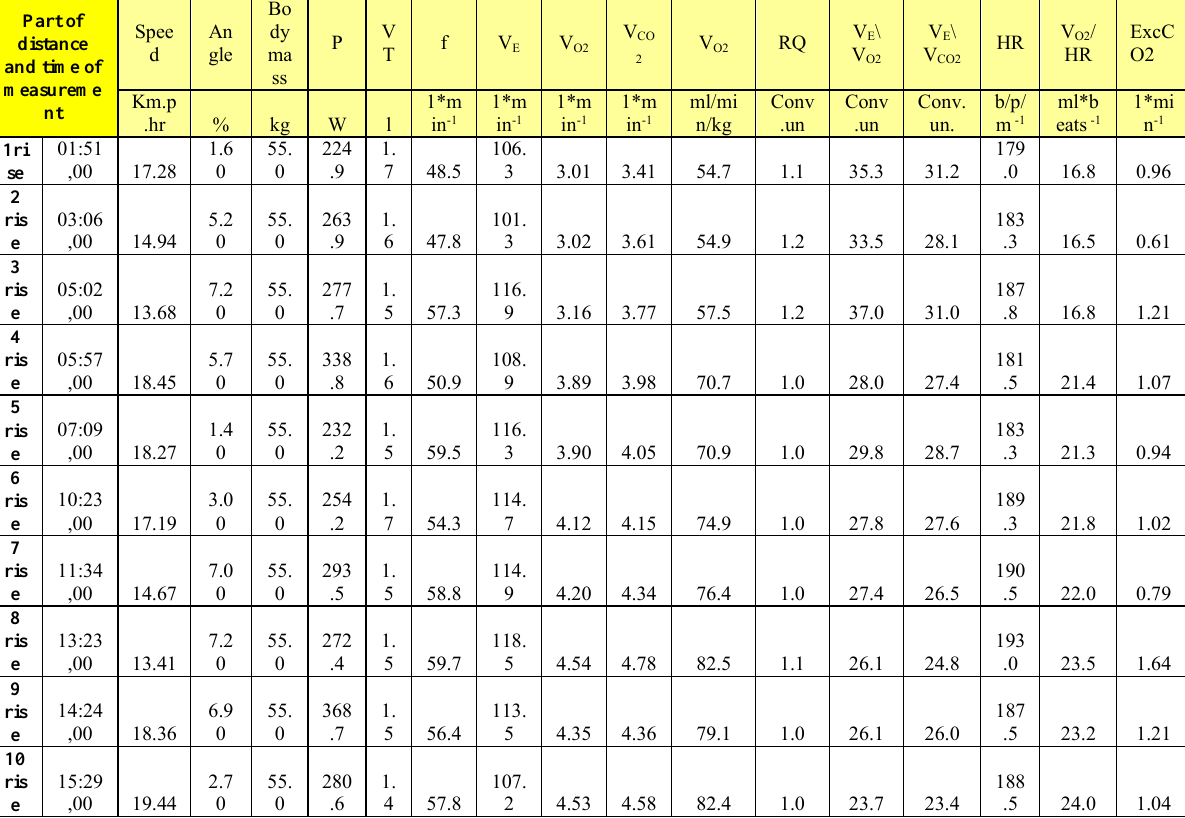
Indicators of female skiers’ functional fitness in conditions simulating passing of competition distance at the end of training